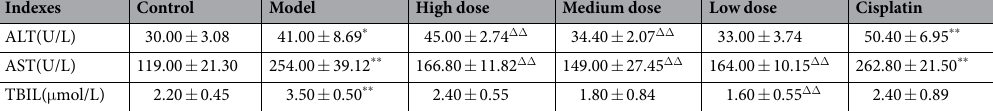
Table 1. Effects of GLE on serum hepatic function in tumor-bearing mice. Note: * P < 0.05; ** P < 0.01, versus control values; Δ P < 0.05; ΔΔ P < 0.01, versus model values.